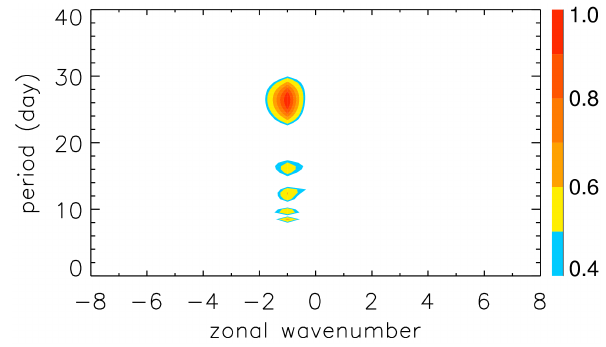
Figure 3. Normalized period–wavenumber spectrum of TIMED/SABER temperature at 85km over 20 ◦ N.